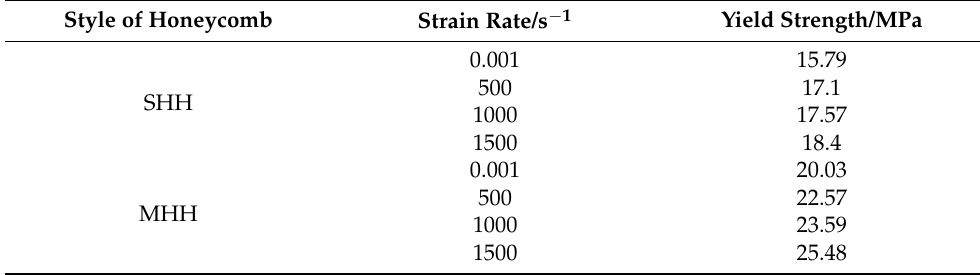
Figure 11. The yield strength of resin hierarchical honeycombs under different strain rates. Table 3. The yield strength of resin honeycombs under different strain